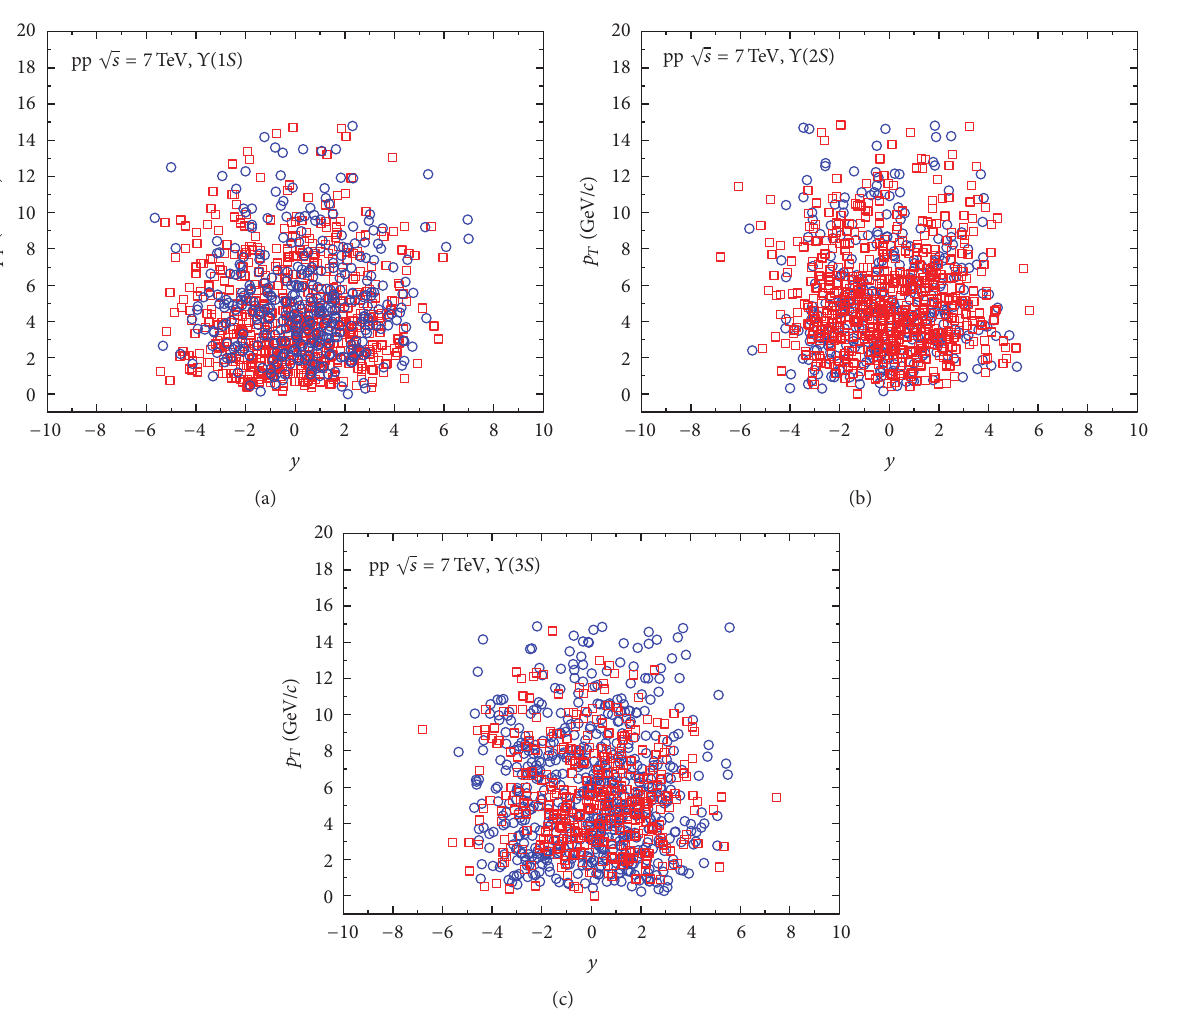
𝜒 2 /dof are listed in Tables 1 and 2. One can see that the results calculated by using the hybrid model are in agreement with the experimental data of quarkonium states ( 𝐽/𝜓 , Υ(1𝑆) , and Υ(2𝑆) ) measured by the ALICE and CMS